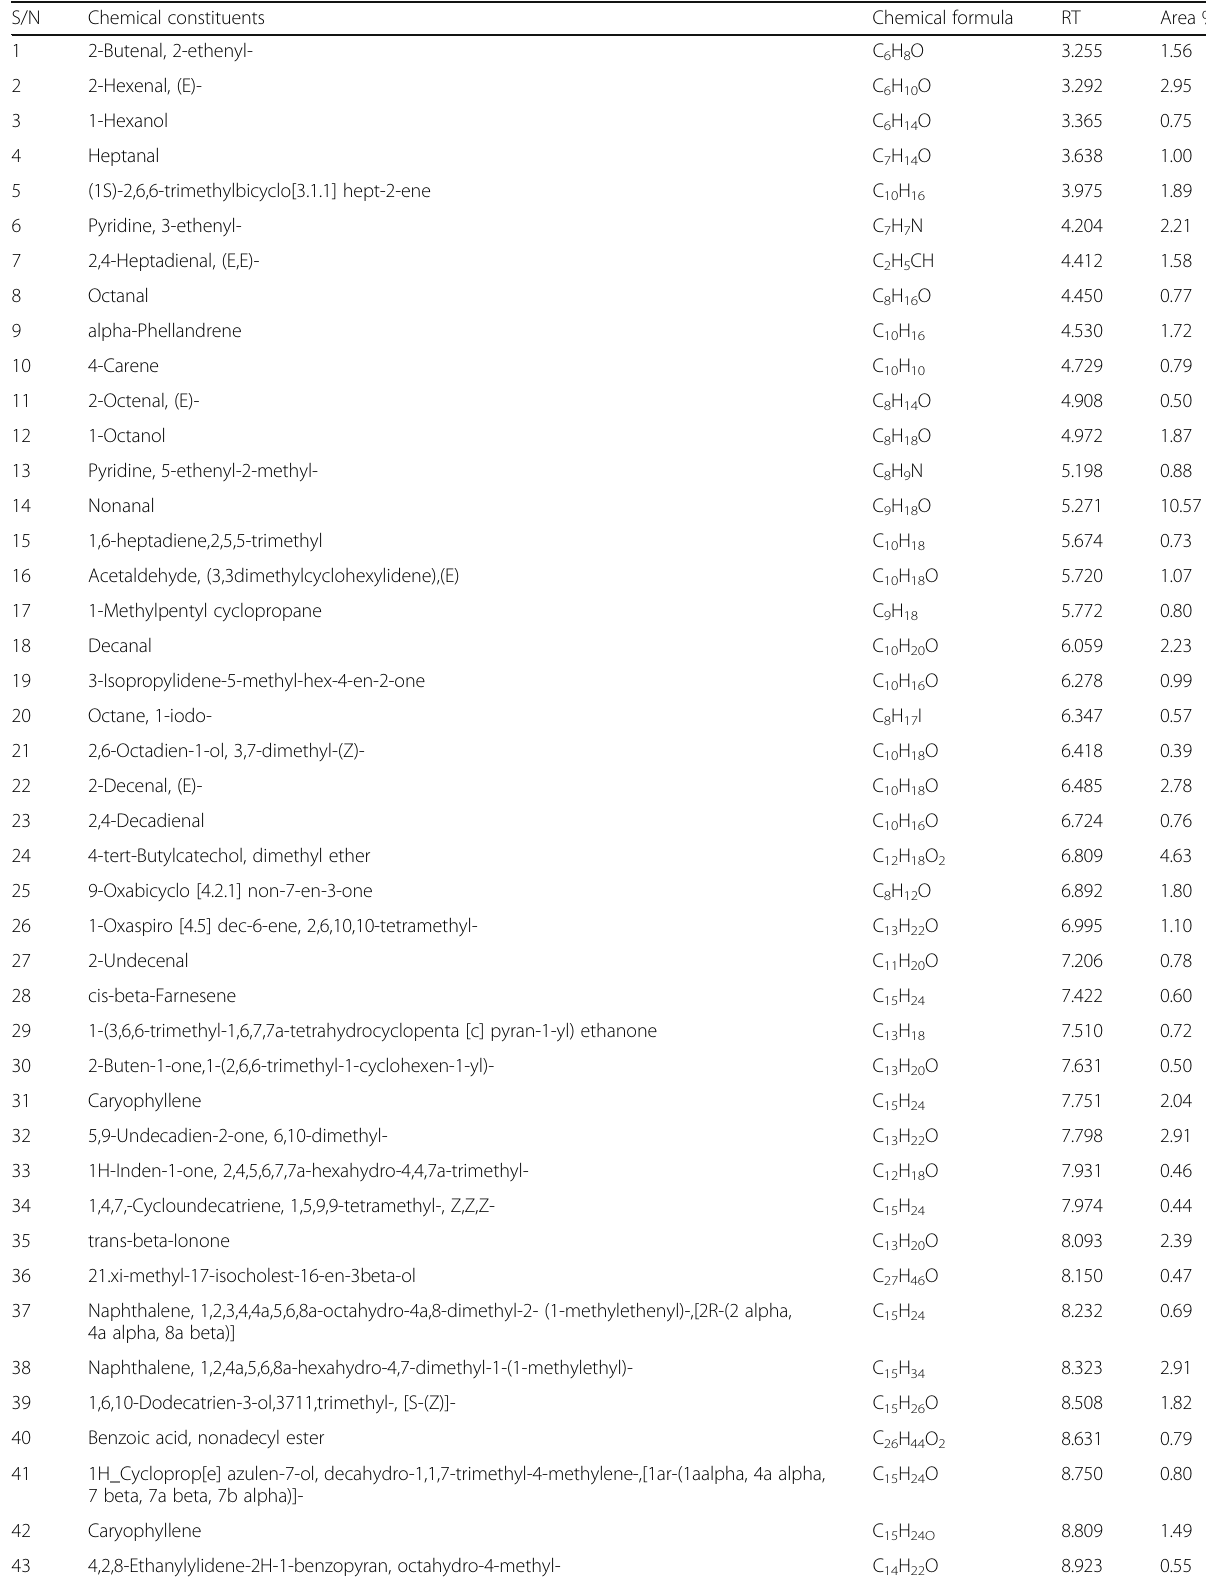
Table 3 Chemical composition of essential oils of Olea